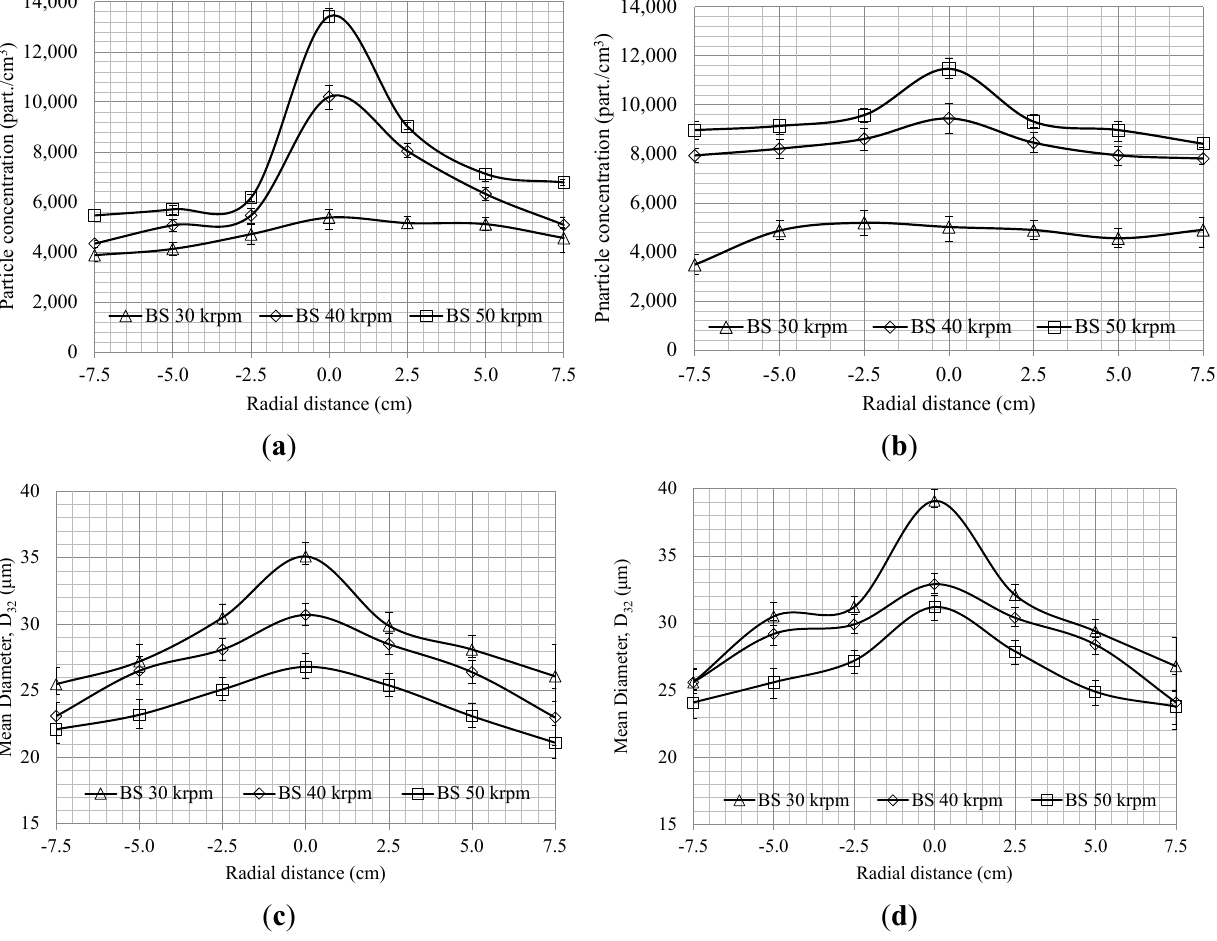
Figure 1. Particle concentration (part./cm 3 ) with increasing bell speed for ( a ) 100 cm 3 /min flow rate; ( b ) 200 cm 3 /min flow rate; particle mean diameter D 32 ( μ m) with increasing bell